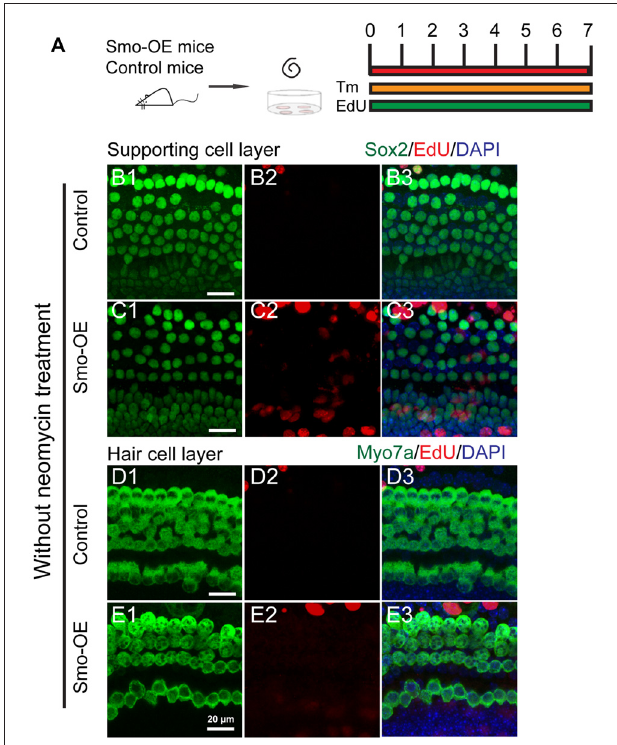
FIGURE 3 | Forced activation of Hedgehog signaling did not trigger cell proliferation or new HC formation in the cochlear epithelium without neomycin treatment. (A) The diagram for the assay. Cochlear epithelium samples were dissected from P2 Smo-OE and control mice and then cultured in DMEM/F12 media with N2 and B27. 4-OH tamoxifen (Tm) and EdU were added throughout the culture period. At the end of 7 days of culture, the tissues were fixed and immunostained for Myo7a, Sox2 and EdU. (B,C) Representative immunofluorescence images of the supporting cell layer in the control and Smo-OE cochlear epithelia without neomycin treatment. No difference in the number of EdU+Sox2+ cells was seen between the Smo-OE and control groups. (D,E) Representative immunofluorescence images of the HC layer in the control and Smo-OE cochlear epithelia without